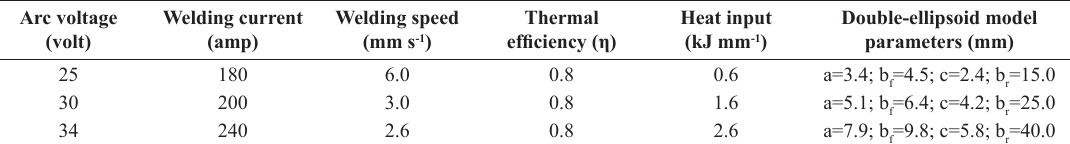
Table 4. Welding and double-ellipsoid model parameters.